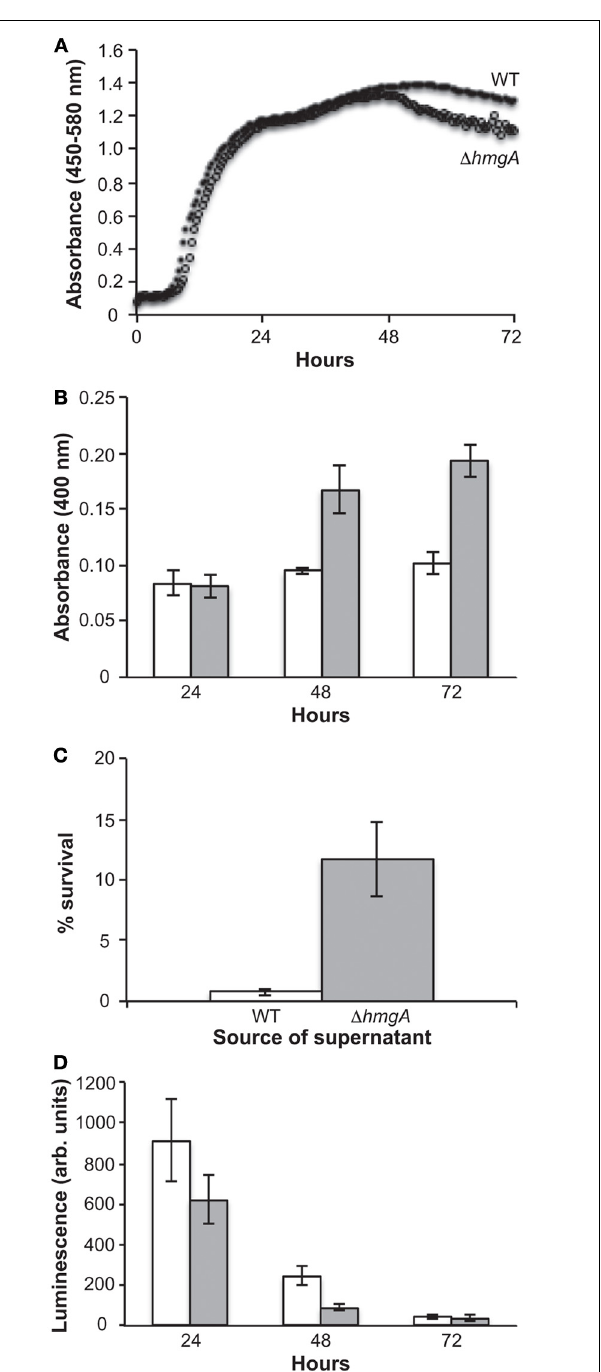
FIGURE 2 | Growth, pigment production and bioluminescence in V. campbellii WT and (cid:2) hmgA . (A) Grow curves of the WT and (cid:2) hmgA strains in LM at 30 ◦ C. WT (closed circle), (cid:2) hmgA (open circle); (B) Absorbance of pigment-containing supernatants. WT (white bars), (cid:2) hmgA (gray bars); ( C ) Survival of WT V. campbellii cells in 2mM H 2 O 2 when resuspended in supernatants from WT or (cid:2) hmgA cultures; (D) Bioluminescence measurements. WT (white bars), (cid:2) hmgA (gray bars). Error bars represent the standard deviation from three